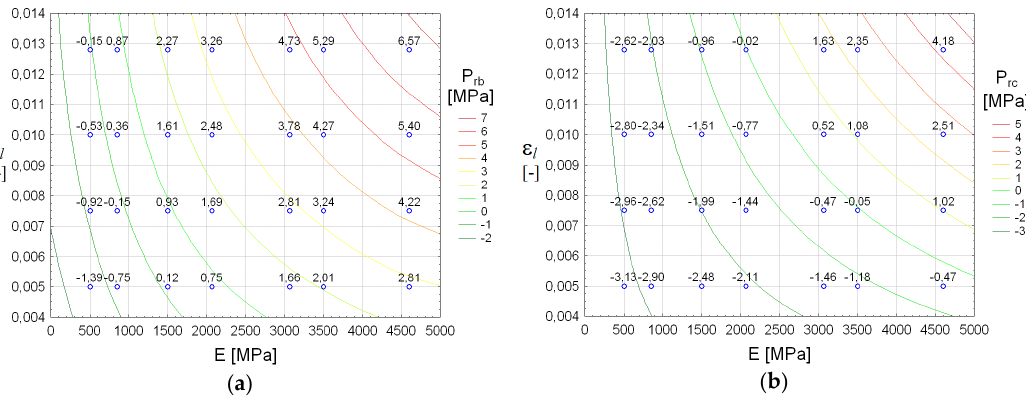
Figure 19. Maps of: ( a ) the rebound pressure P rb ; and ( b) the recovery pressure P rc , as correlated with E and ε l for the Northern San Juan basin.